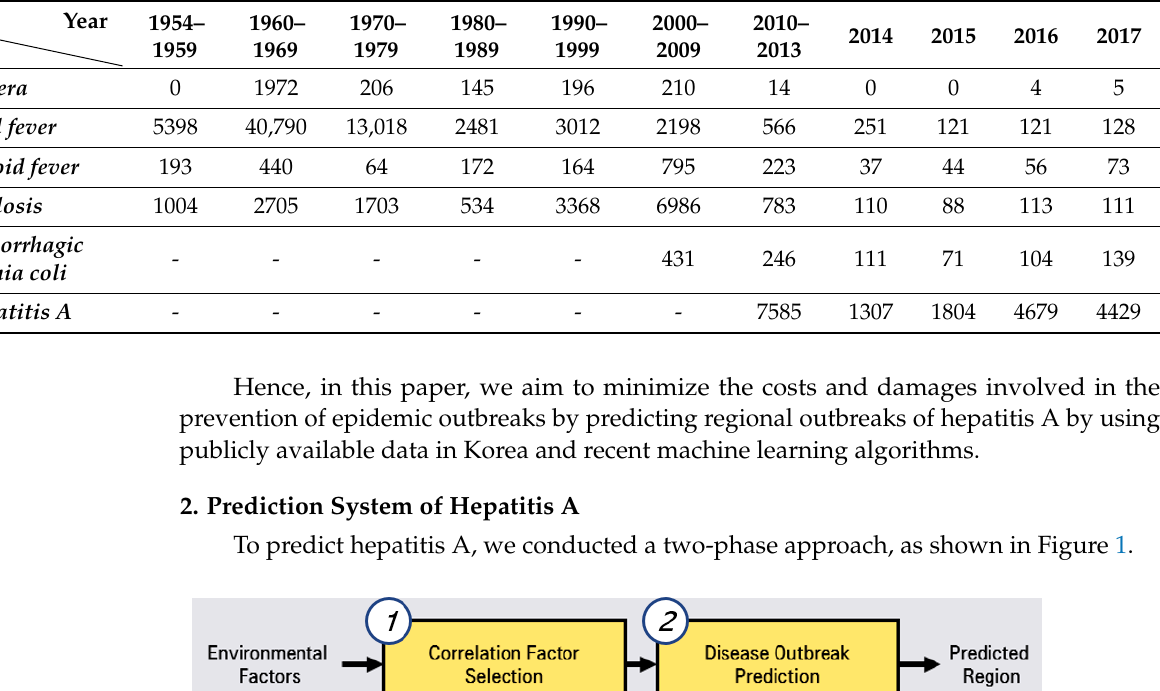
Table 1. Prevalence of National Notifiable Infectious Category I Diseases in Korea (restructured based on [12,13]).